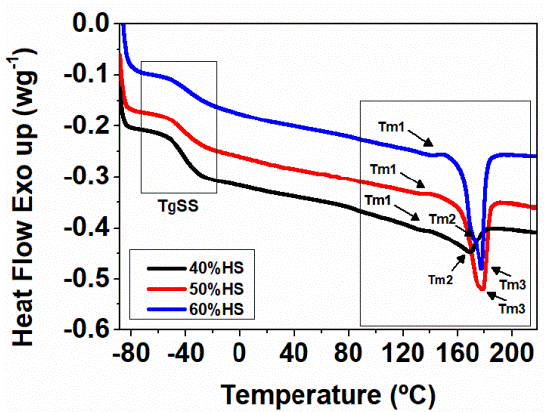
Figure 1. DSC thermograms of the second heating for solid TPUs with different HS contents. Table 3. DSC data of solid TPUs with different HS contents. TPU